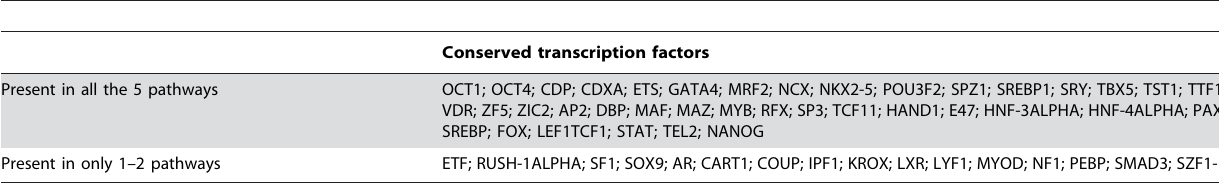
Table 2. ‘‘Conserved’’ transcription factors which showed binding sites among most genes of both human and mouse and statistically over-represented in conserved co-expression